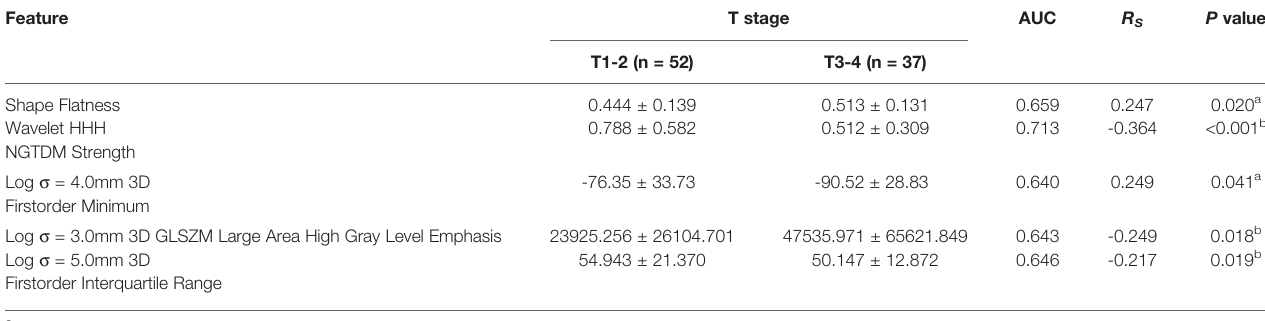
TABLE 1 | Clinical and pathological characteristics of the cases selected for analysis. Characteristics